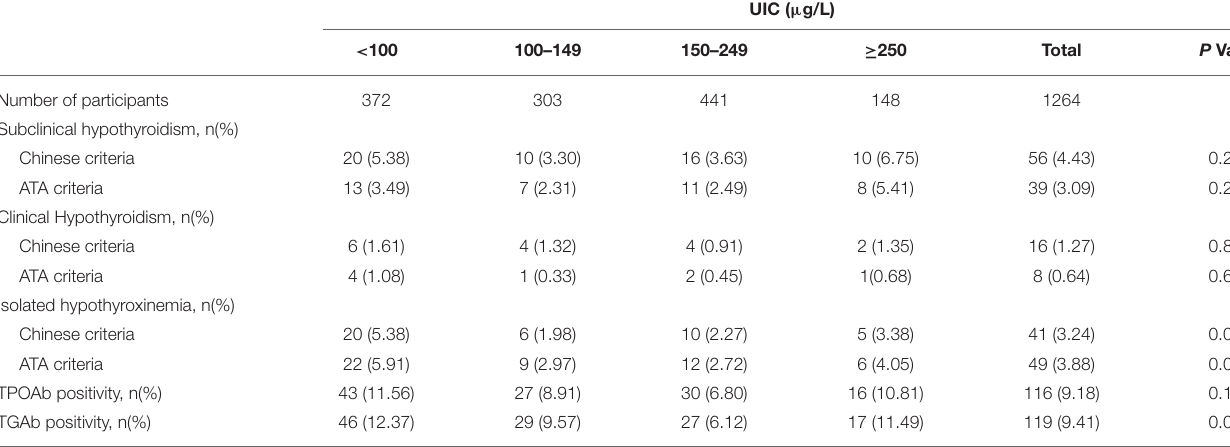
TABLE 3 | Prevalence of thyroid disorders among women by UIC group.